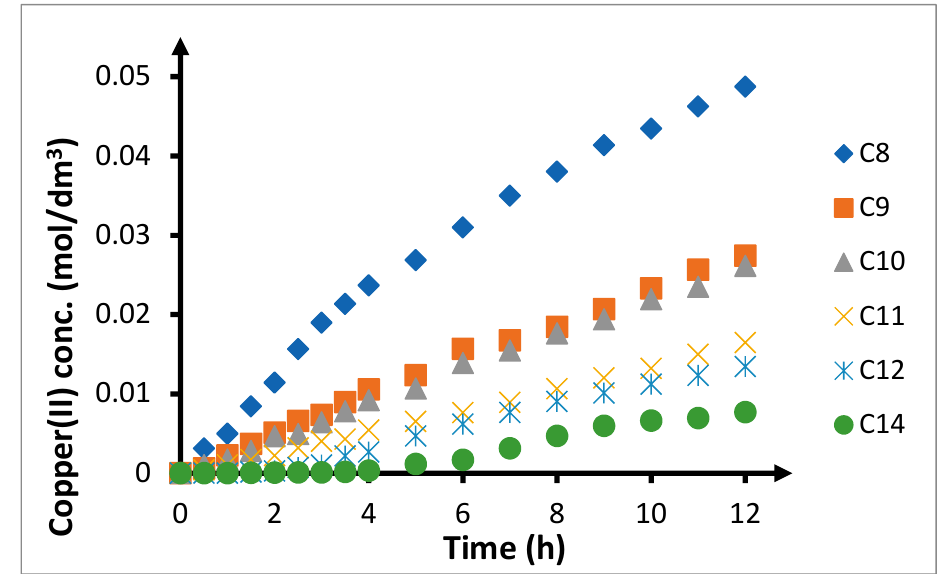
Figure 9. Effect of the chain length of the alkyl substituent on the transfer of copper(II) ions by PIM. The volumetric flow rate is 3.0 cm 3 / min. Feeding phase: CuCl 2 concentration—0.1 mol / dm 3 , chloride concentration—2.0 mol / dm 3 . Receiving phase: demineralized water. Membrane: CTA-ONPOE-TRIA-10. The composition of the membrane is provided in Table 2. Temperature 20 ± 0.5 °C.